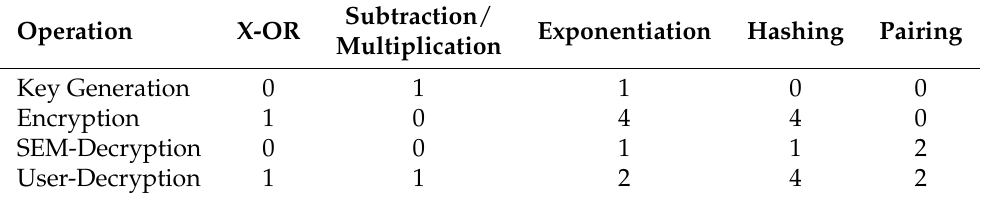
Table 1. Computational Efficiency of The Proposed Mediated ElGamal Encryption Scheme. Operation